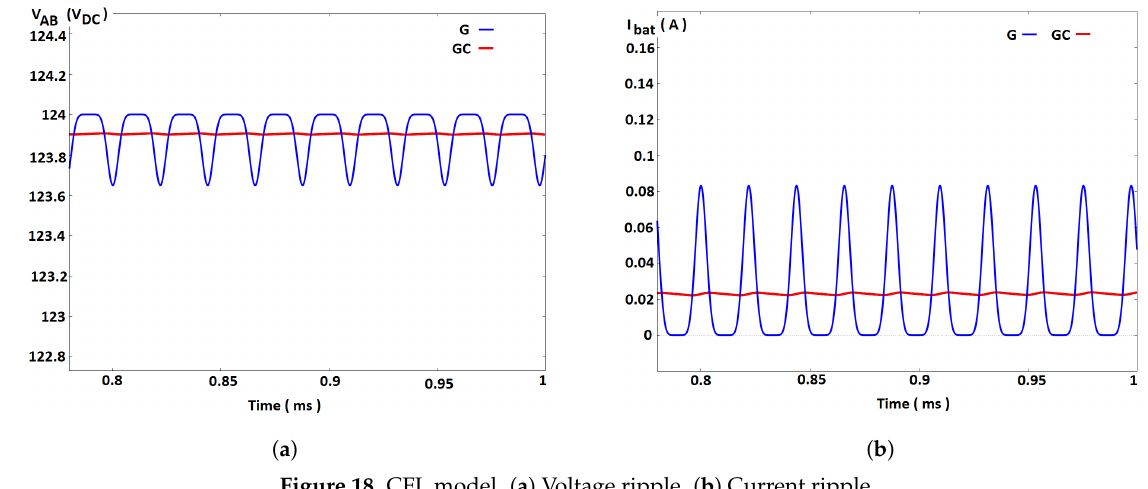
Figure 18. CFL model. ( a ) Voltage ripple. ( b ) Current ripple.